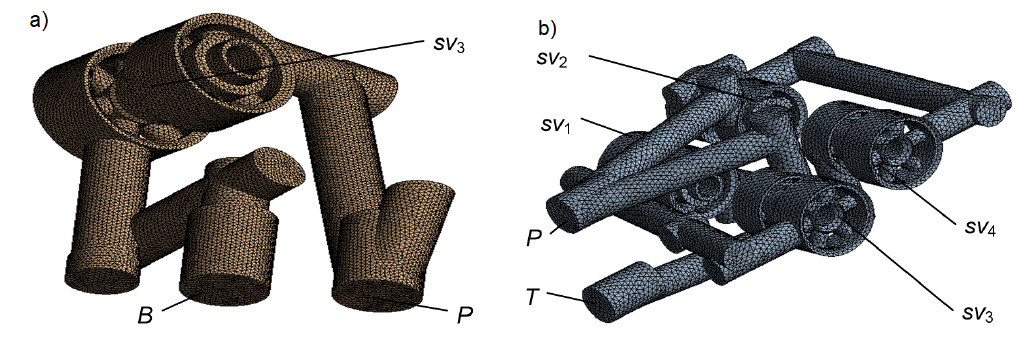
Figure 9. Meshed models: ( a ) P − B line, ( b ) P − T line; sv 1 , . . . sv 4 —seat